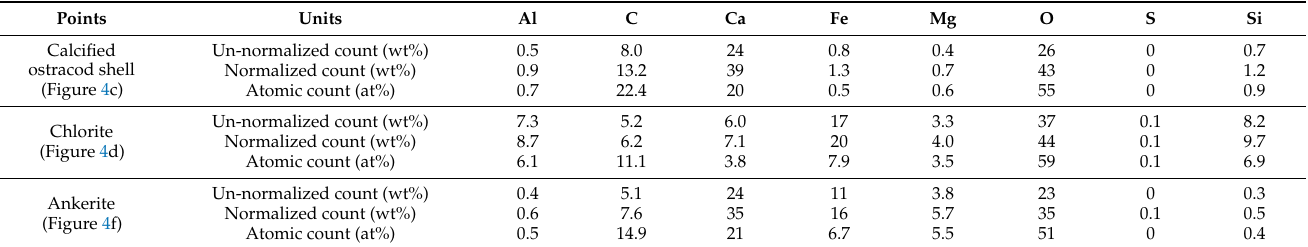
Figure 4. Scanning electron microscope photographs of the studied ostracods. ( a , b ) are appearances of well-preserved ostracod shells. ( b ) is Triangulicypris torsuosus Netchaeva. nota Ten with a tubercle. ( c ) is Triangulicypris torsuosus Netchaeva with a smooth shell. ( d ) is a broken ostracod filled with chlorite and ankerite. ( e ) is a broken ostracod filled with ankerite. ( f ) is the enlargement of marked area in ( e ). Energy dispersive X-ray spectroscopy (EDS) analysis was performed on the points with yellow cross forks in panels ( c , d , f ). The EDS data are shown in Table 2. Table 2. Elemental contents of different points on sample based on SEM-EDS